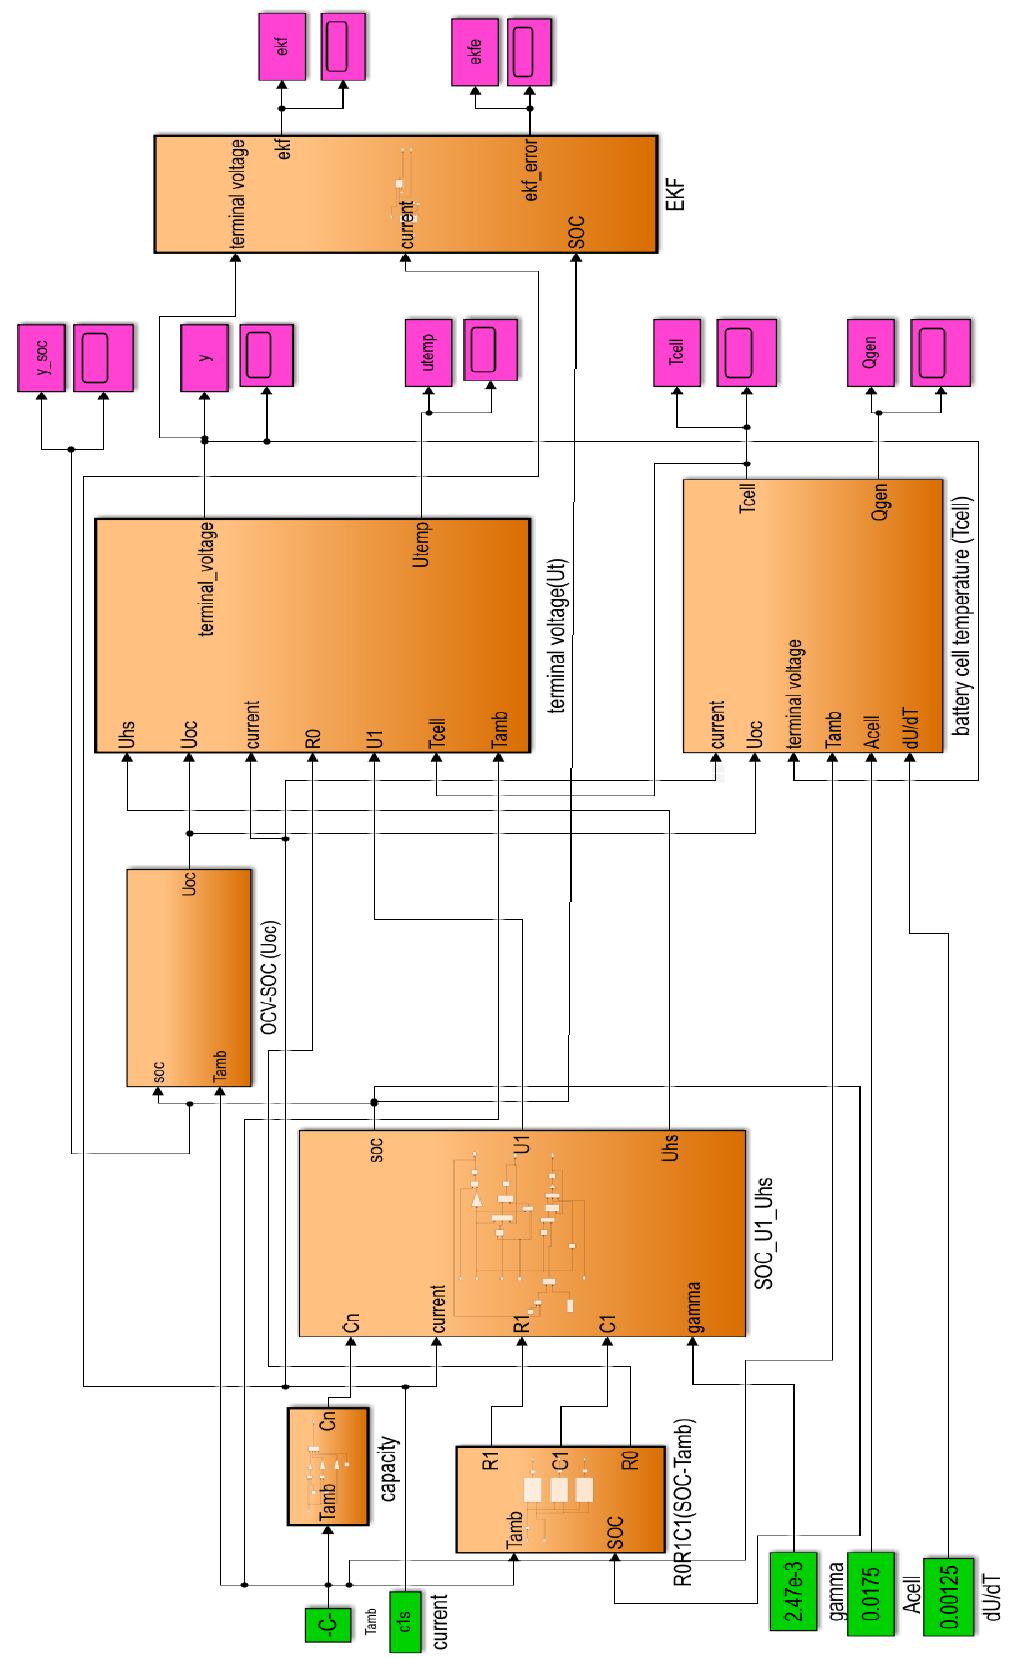
Figure 14. Simulation block diagram for battery cell model.